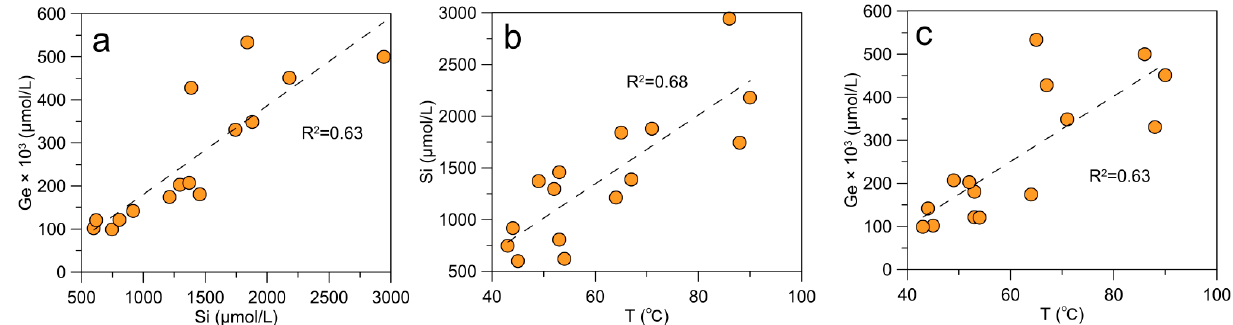
Figure 3. Correlations between dissolved Si and Ge ( a ), water temperature and Si ( b ), and water temperature and Ge ( c ) in hydrothermal waters.